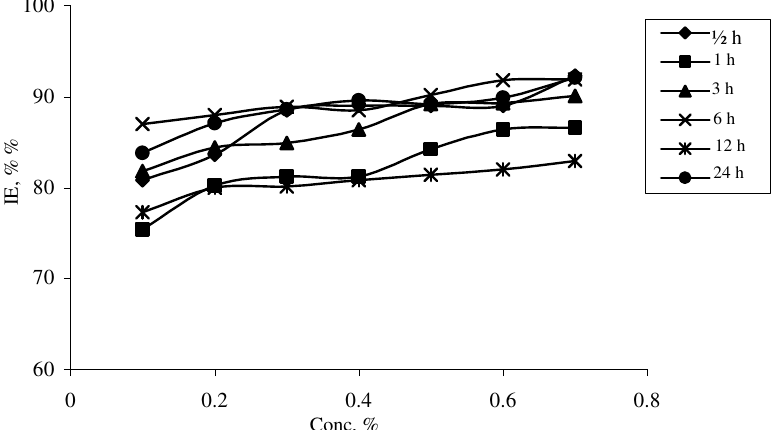
Figure 1 . Effect of CT extract on corrosion inhibition of mild steel in 1 M